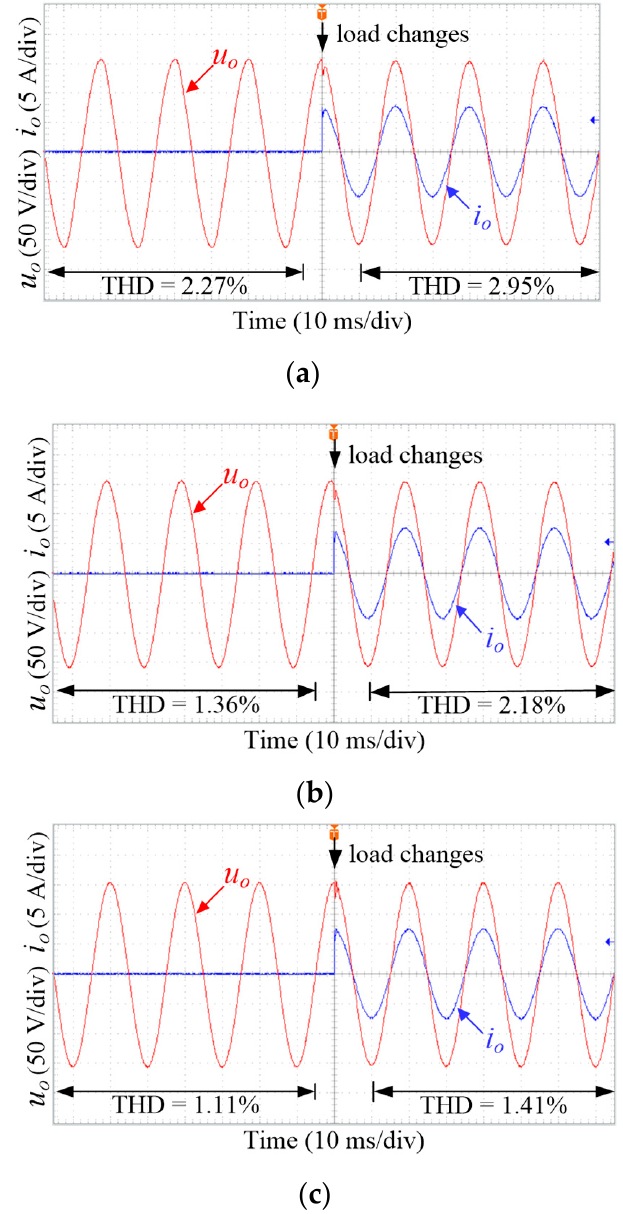
Figure 16. Transient waveforms of different control strategies in response to no load to rated load (20 Ω ) step change with ( a ) LADRC; ( b ) SRFPI-LADRC; and ( c ) HC-LADRC-SRFPI.